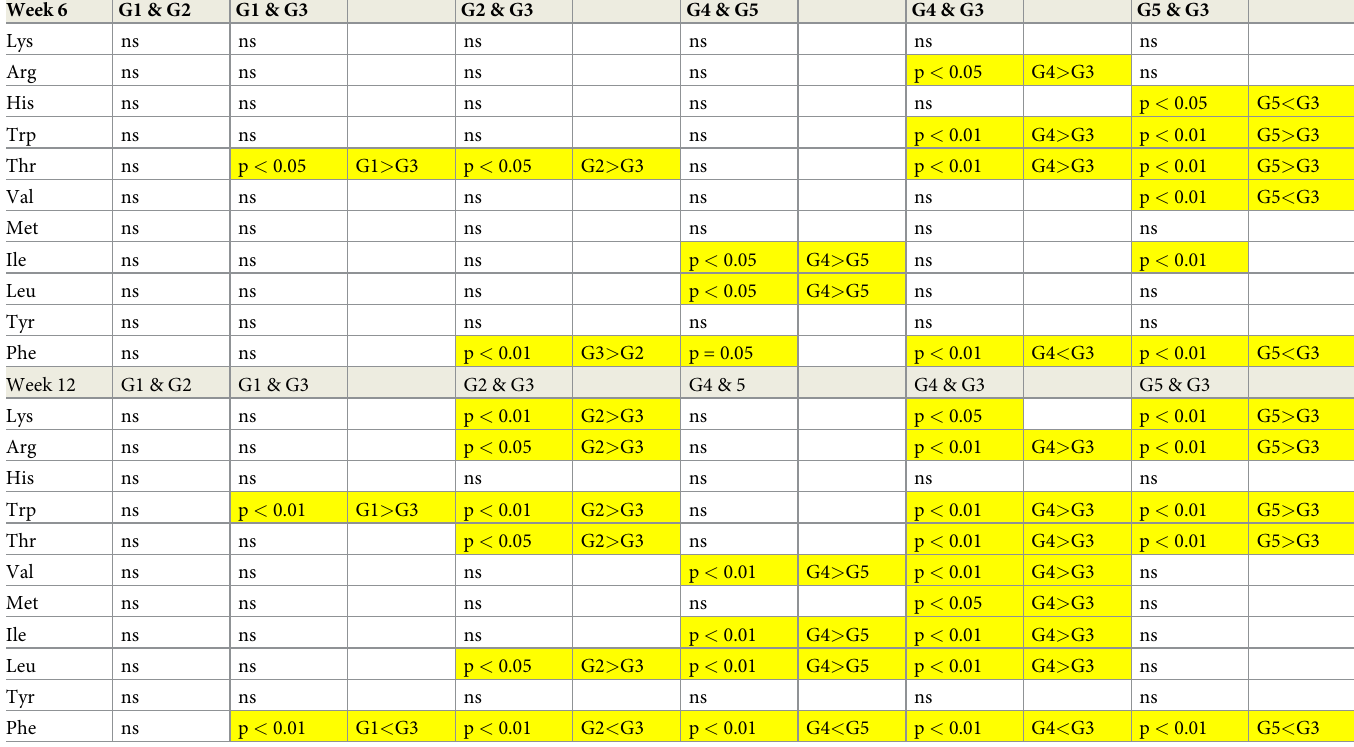
Table 3. P-values for comparison of the different groups G1-G5, representing G1(N-CGMP), G2 (N-CGMP-LNAA), G3 (N), G4 (CGMP-EAA-LP) and G5